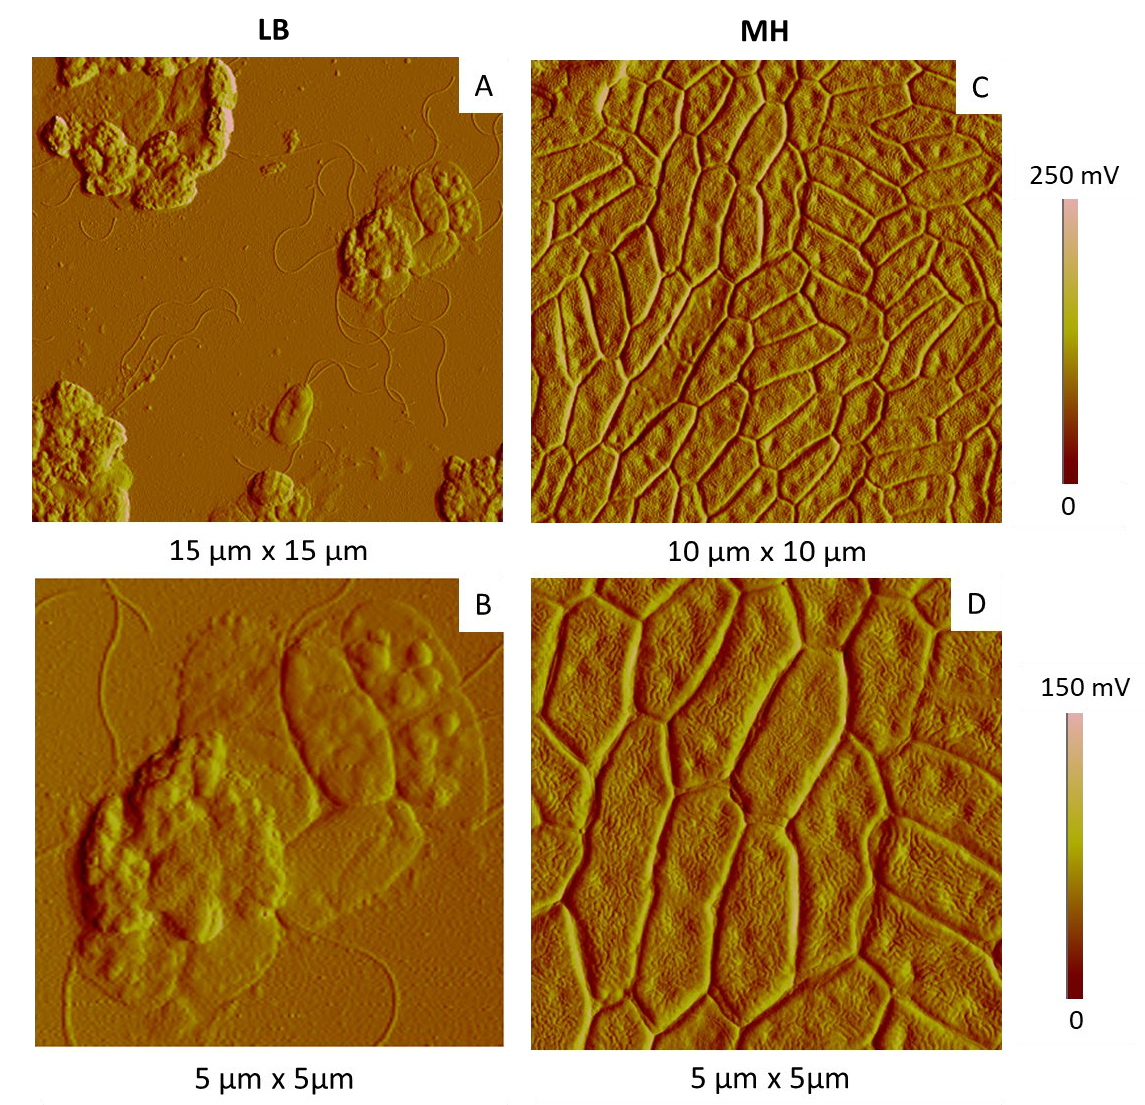
Figure 9. AFM amplitude images of P. fluorescens bacteria of second generation deposited by simple deposition from a culture in LB ( A , B ) and MH ( C , D ) media (15 h, 28 °C).